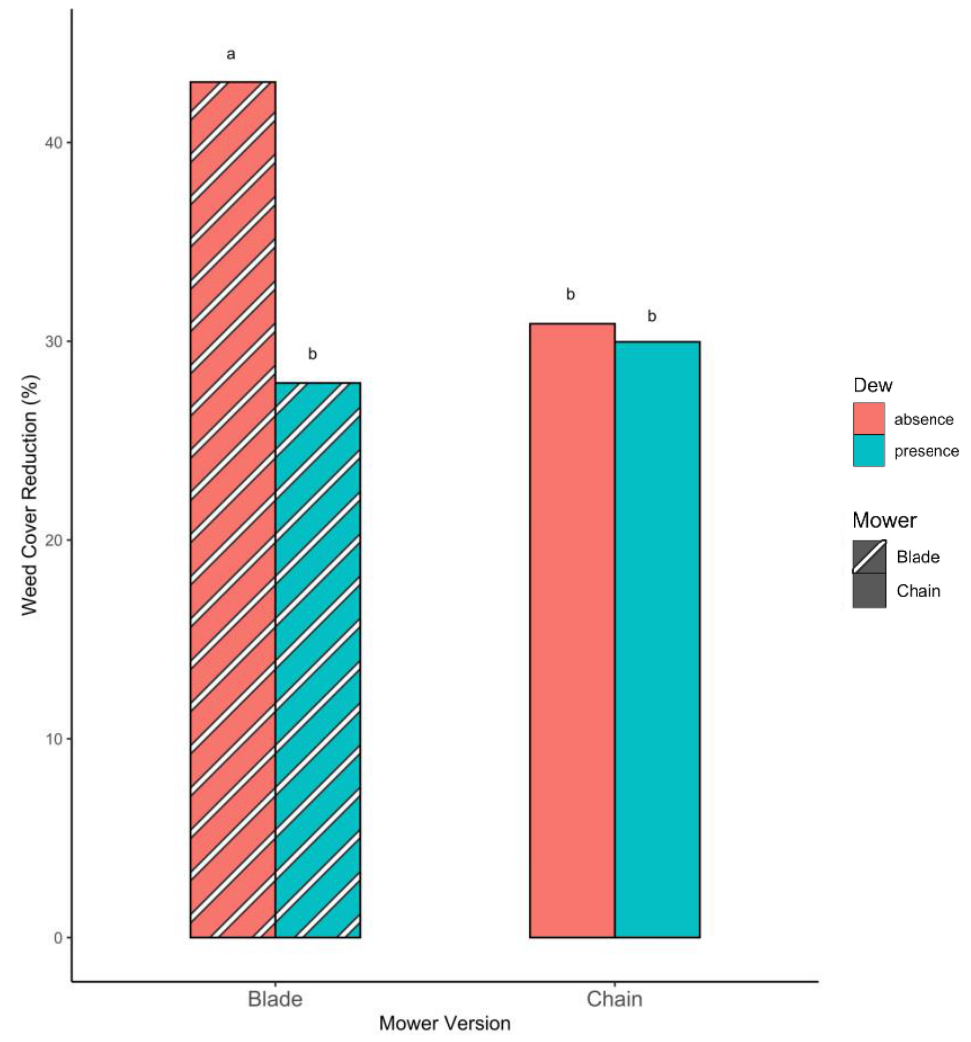
Figure 13. Effect of the interaction between mower version and dew conditions on weed cover reduction. Means denoted by different letters are significantly different at p < 0.05 (LSD test). Dew did not affect weed height reduction within the individual combinations of mower version and setting, with the exception of the chain mower with the Lws + Hrs setting (Figure 14). The chain mower with the Lws + Hrs setting in the presence of dew obtained a higher weed height reduction (53.6%) compared to the absence of dew (34.6%) and compared to the same mower with Hws + Hrs and Lws + Lrs settings in both dew conditions (with weed height reduction of 27.0% and 33.1% for Hws + Hrs setting, and of 31.9% and 33.8% for Lws + Lrs setting in the absence and the presence of dew, respectively). No differences emerged between the chain mower with the Lws + Hrs setting in the presence of dew and the same mower with the Hws + Lrs setting in absence of dew, while the Hws + Lrs setting in the presence of dew achieved a lower weed height reduction (34.8%) ( p < 0.05). The blade mower with the Hws + Hrs setting in the absence of dew achieved a higher weed height reduction (64.3%) compared to the same mower with the other settings in both dew conditions (ranging from 36.9% to 44.6% in the absence of dew and from 42.9% to 47.8% in the presence of dew) ( p < 0.05). The blade mower with the Hws + Hrs setting in the absence of dew obtained a higher weed height reduction compared to the chain mower with different settings ( p < 0.05), with the exception of the chain mower with the Lws + Hrs setting in presence of